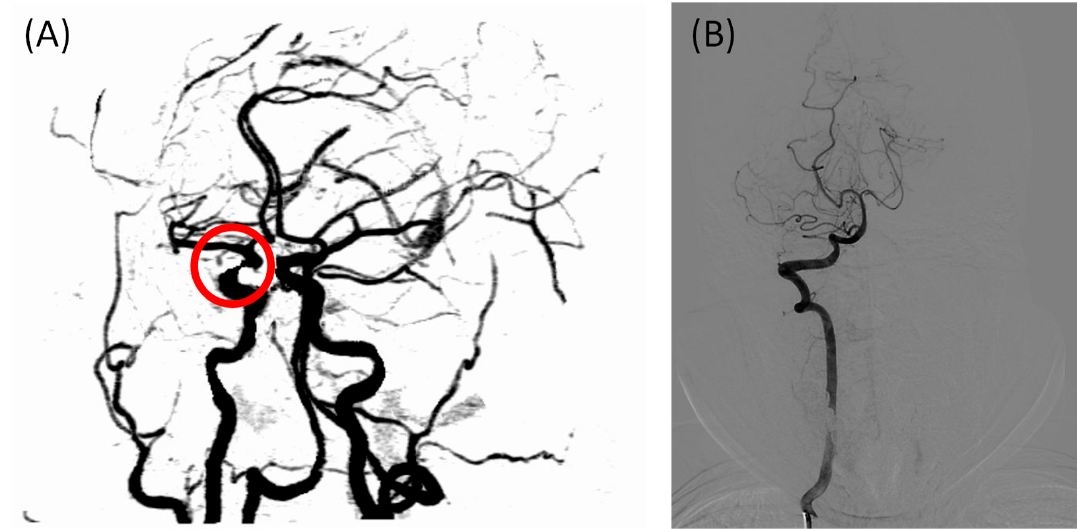
Figure 5. Incorrectly labeled case in the CTA scan due to an insufficient contrast agent, with the FHR in the normal range: ( A ) CTA image of the intracranial arteries of the patient, with the misdiagnosed intracranial internal carotid artery stenosis indicated in the red circle; ( B ) gold standard intracranial digital subtraction angiography image of the same patient showing no stenosis in the arteries, which is consistent with the FHR-based diagnosis. CTA, computed tomography angiography; FHR, first harmonic ratio.